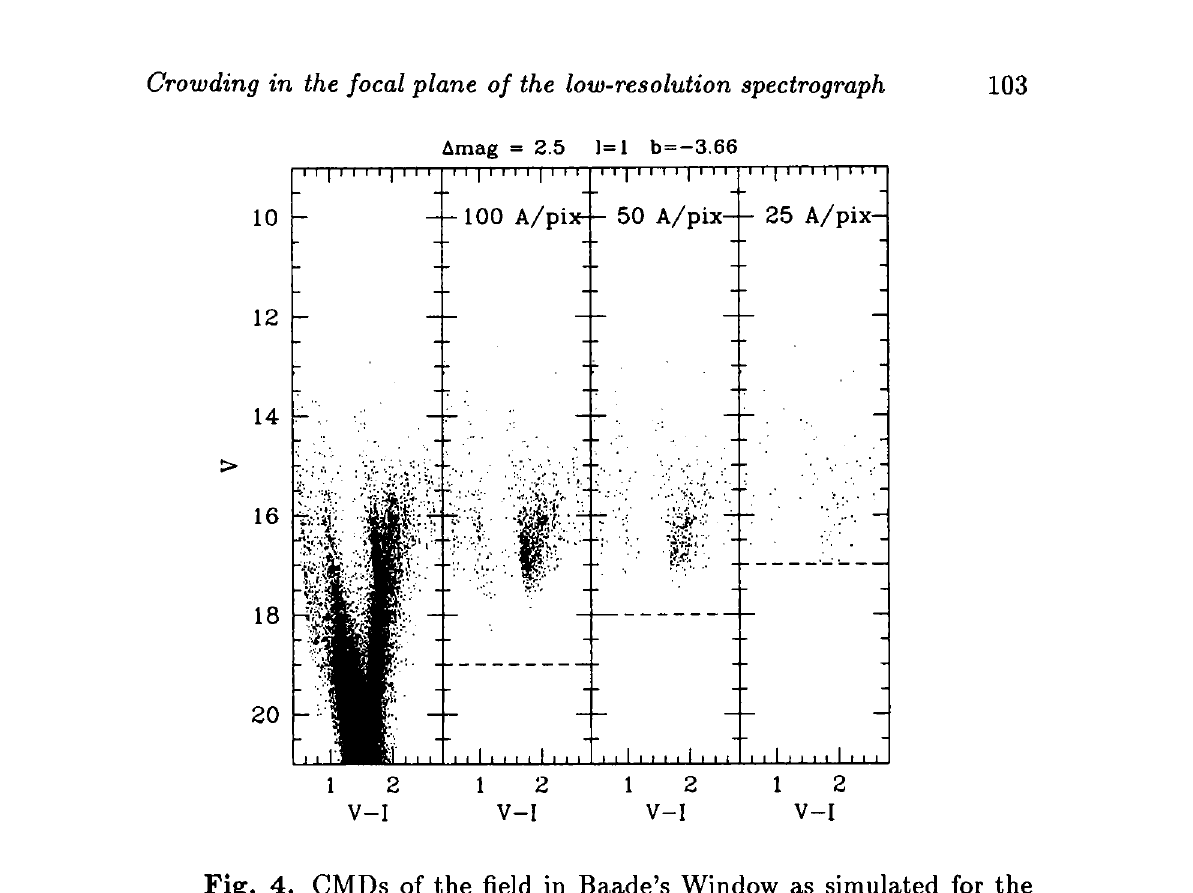
Fig. 4. CMDs of the field in Baade's Window as simulated for the Gala's low resolution spectrograph (scale 0.5 as/pix) according to the data of Fig. 2. The left panel is the original simulation, the remaining panels are for Δ V— 2.5 mag and different spectral resolutions. The horizontal dashed lines mark the V magnitude corresponding to a S/N ratio of about 5.